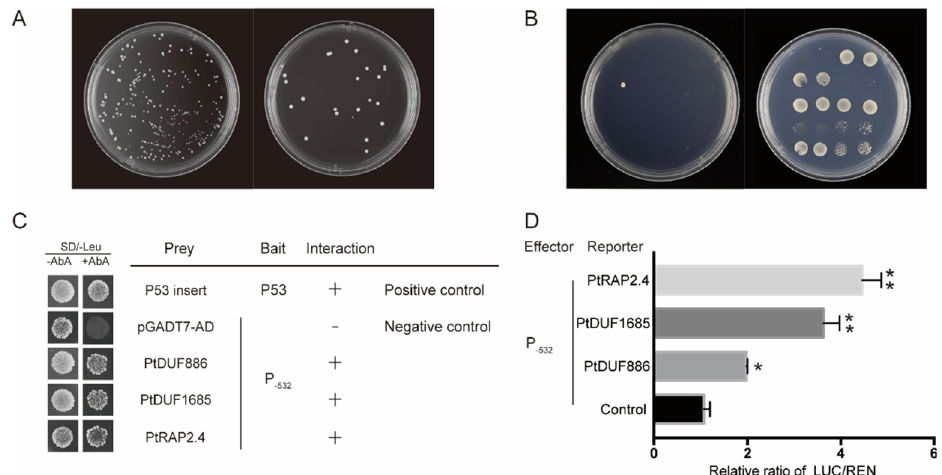
Figure 6. Isolation and identification of proteins interacting with the PtAOS1 promoter. ( A ) Yeast library transformation and capacity identification; ( B ) screening and re-selection of positive clones on SD / -Leu with 350 ng / mL AbA; ( C ) growth of yeast strains co-transformed with prey and bait, negative control (bait / pGADT7) and positive control (p53 / pGADT7-53) on selective medium; ( D ) dual luciferase assay by transient expression in tobacco. Asterisks indicate significant di ff erences between drought treatment and control (*, p < 0.05 and **, p <